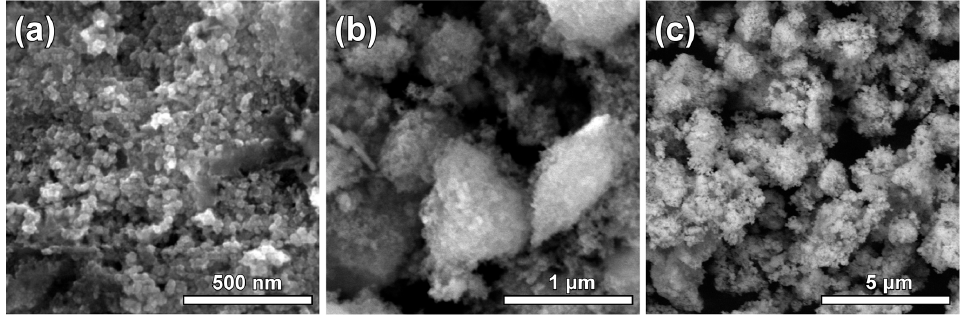
Figure 4. SEM images of ( a ) single-phase Fe 3 O 4 sample; ( b ) single-phase FeOOH sample; and ( c ) Fe 3 O 4 /FeOOH 50 wt % nanocomposite.